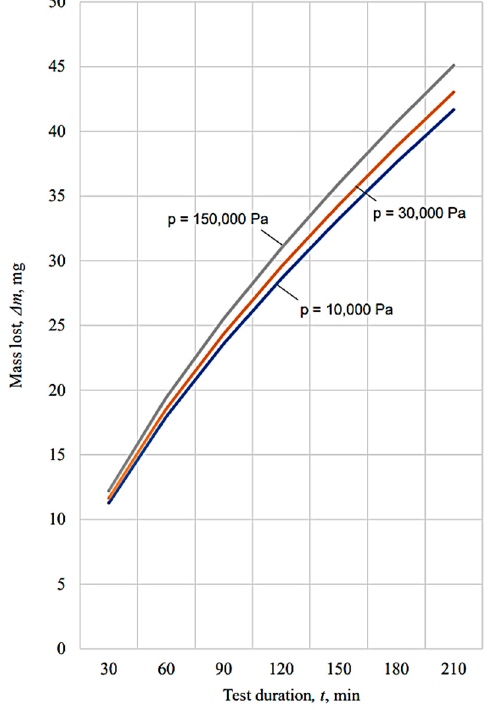
Figure 14. Influence exerted by the process duration t on the mass lost ∆ m for different pressures p applied to the tested surface in the case of the vibroburnishing process.